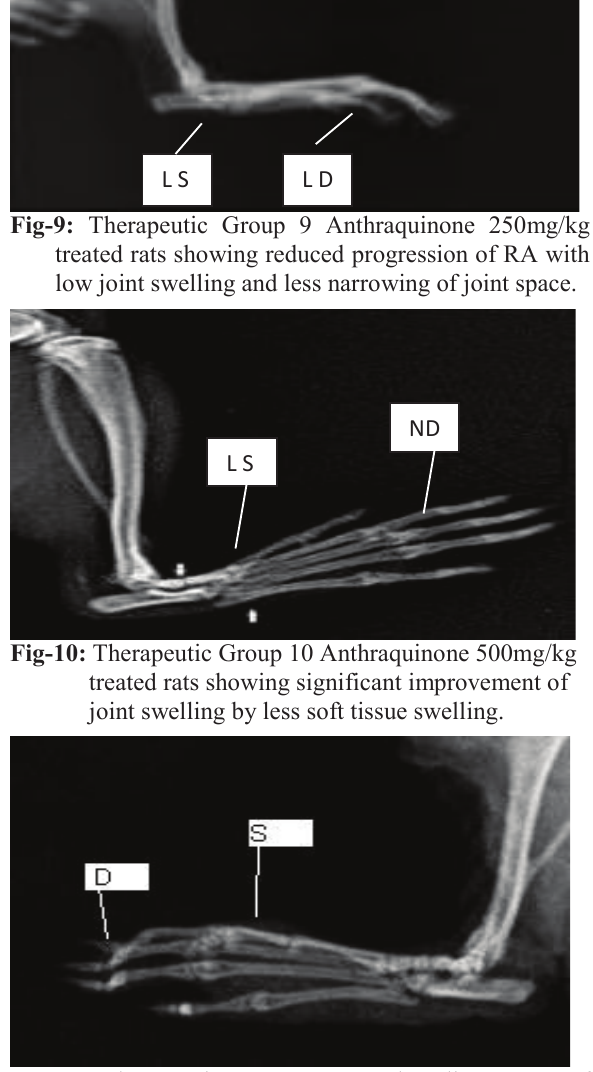
Fig-11: Therapeutic Group 11 Methanolic extract of Cassia fistula 250mg/kg treated rats shows swelling (S) of hind paw and deformity (D) of interphalangeal joints.